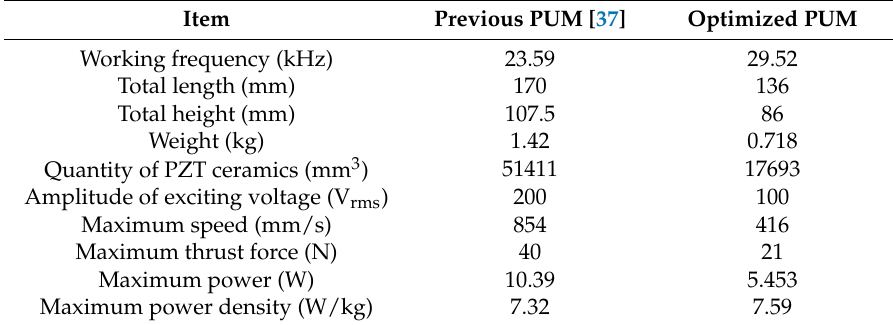
Table 2. The comparison between the previous similar PUM and the optimized